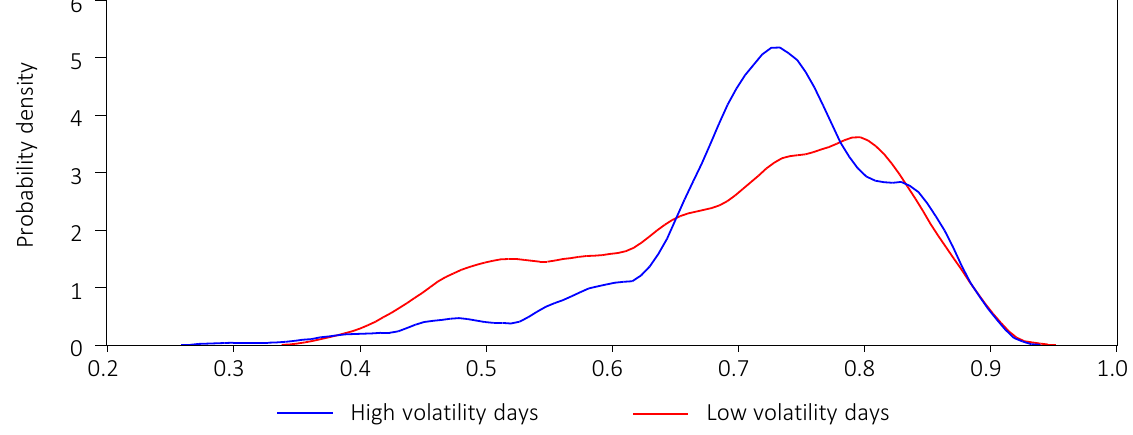
Figure 2(a). Distributions of DCC between Tokyo and London gold markets on low and high volatility days